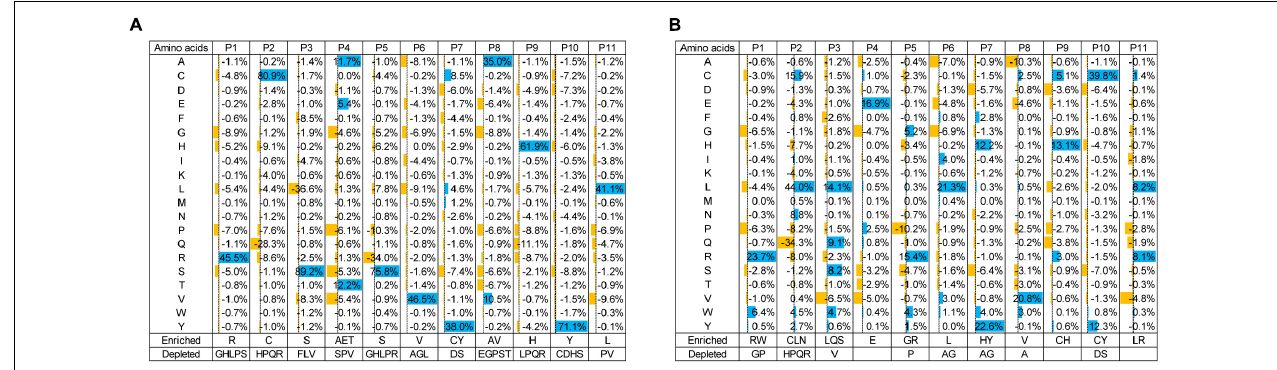
FIGURE 3 | Proportion changes of residue types at evolvable positions from the naïve library to the library at the fourth round of selection against pTyr (A) and sTyr (B) . Residue types with significant proportion changes (5% as cutoff) were considered enriched or depleted and were listed at the